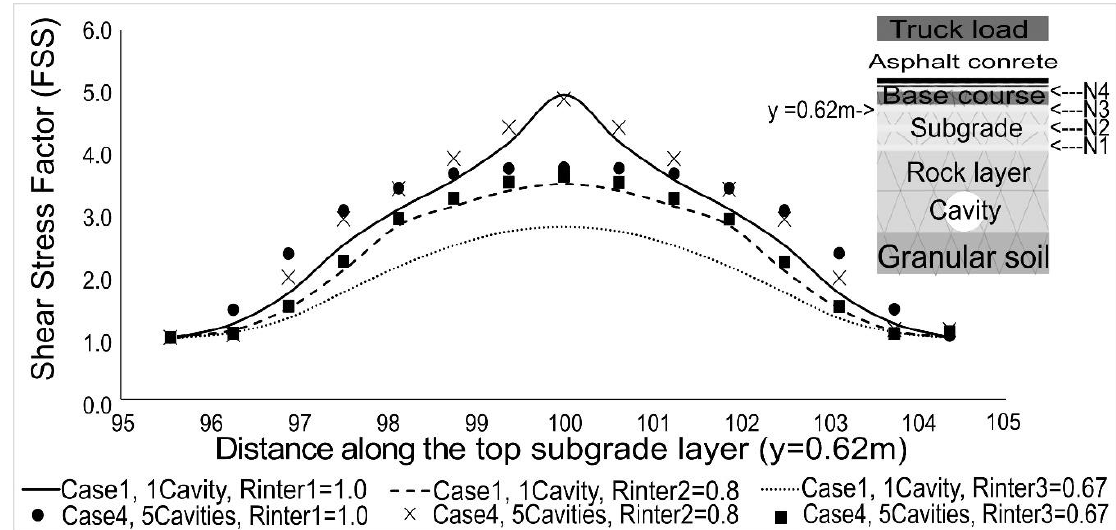
Figure 7. Mobilized FSS along of the road layers y=0.0m and y=0.92m considering the truck load acting in the surface without geogrids in the road structure and 0, 1 and 19 cavities.